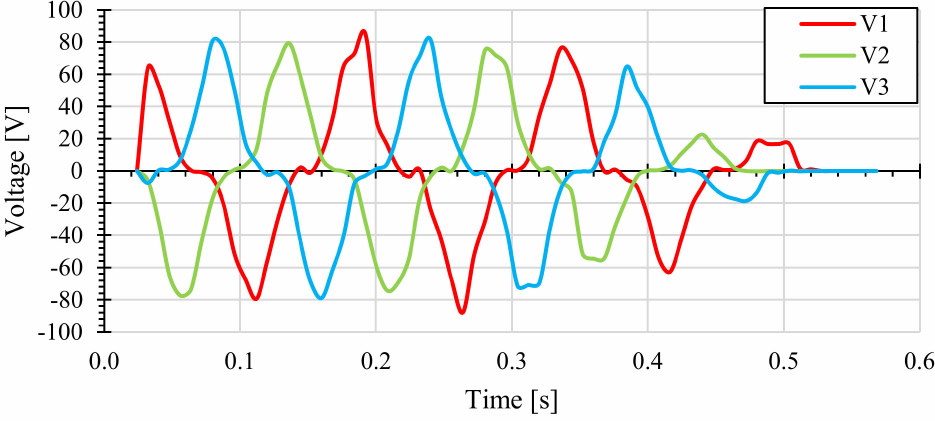
Figure 6. Voltages from open circuit FEM simulation at 1 m/s by using the iron